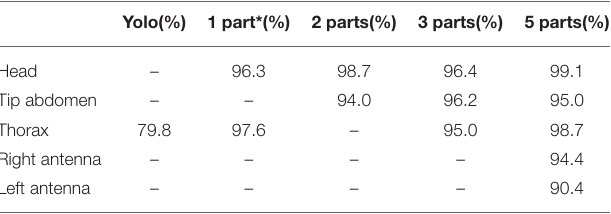
TABLE 3 | Confusion matrix of entrance and exit detection. Rows represent the manual annotation of each corresponding track